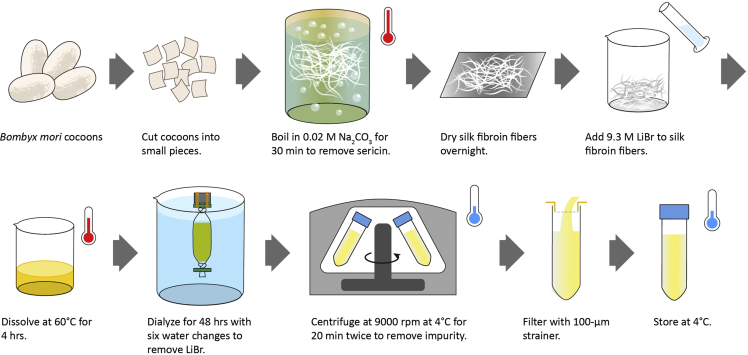
Preparation of silk fibroin solutionSee also Methods Videos S1, S2, S3, S4, and S5.